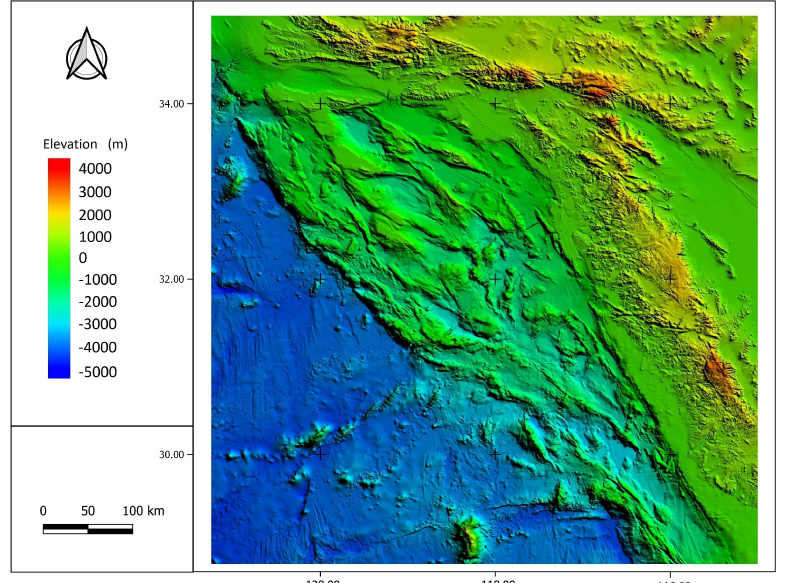
Figure 2. Bathymetry of the study